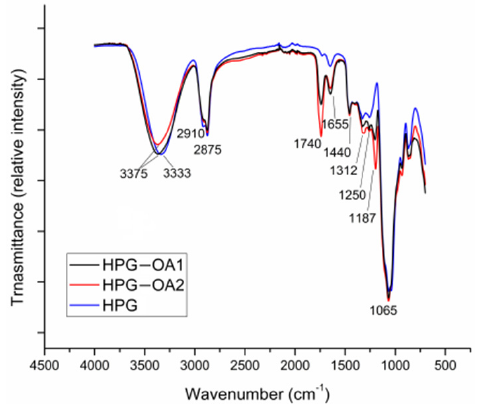
Figure 3. FTIR spectra of HPG-OA1, HPG-OA2 and hyperbranched polyglycerol (HPG). The main peaks associated with the structures are highlighted.